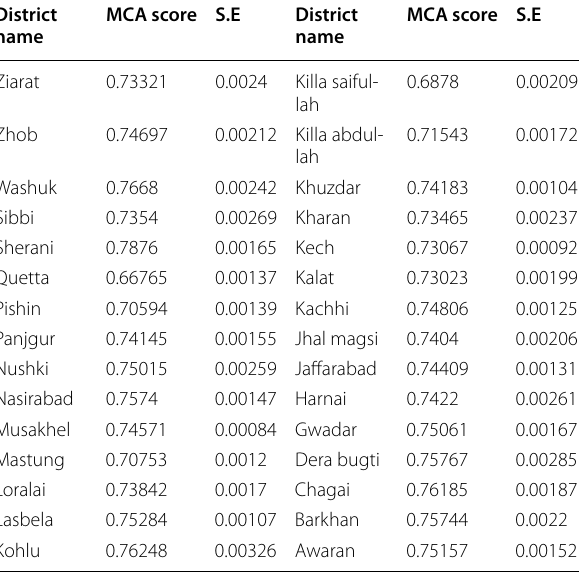
Table 8 Mean score of asset-based poverty index for districts